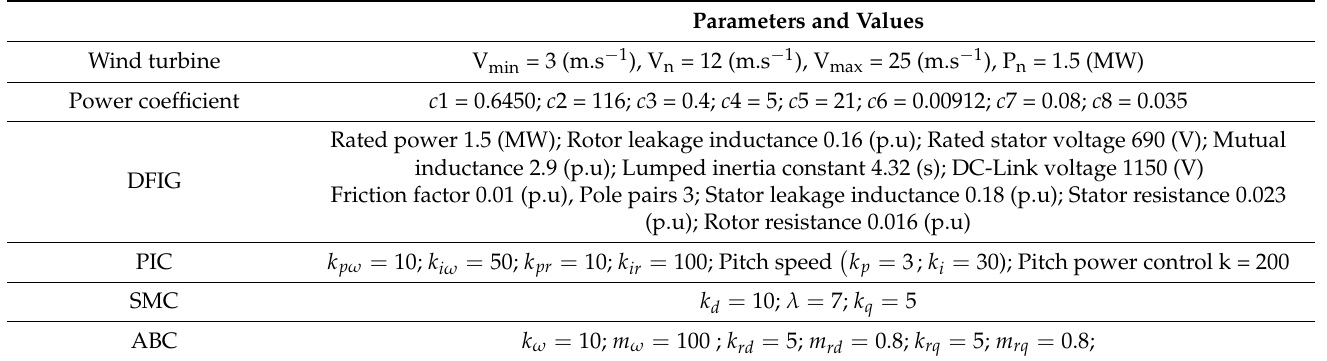
Table A1. Parameters and